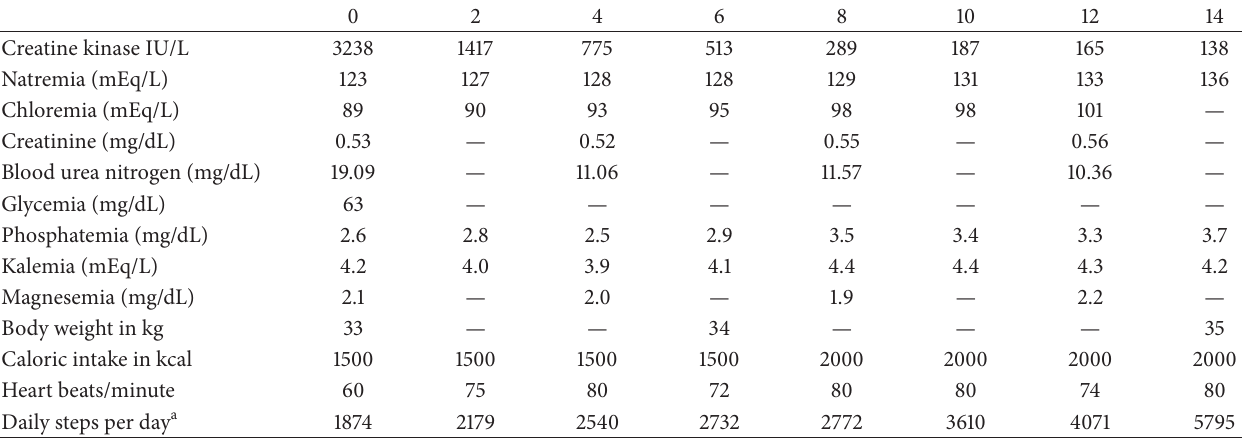
Table 1: Changes in clinical and laboratory variables in the two weeks following